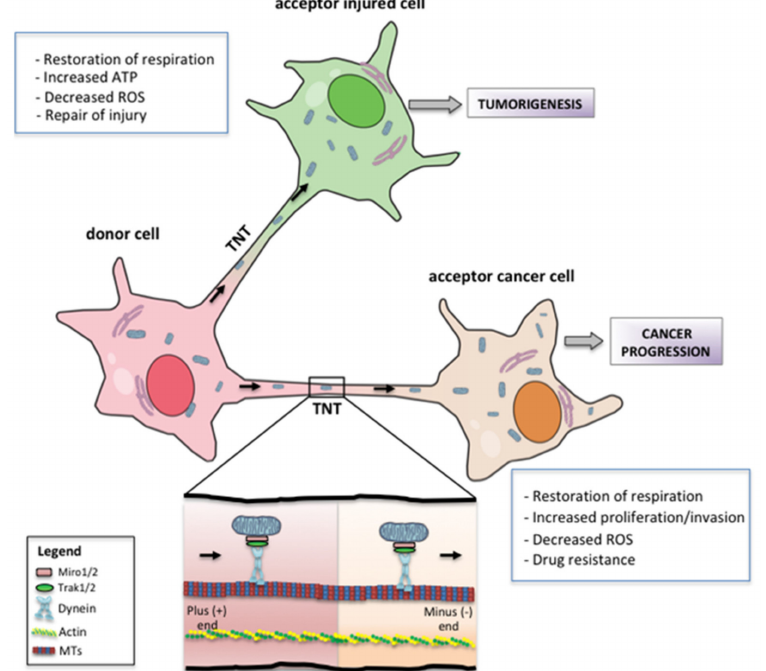
Figure 5. Mitochondrial transfer: Schematic representation of mitochondrial transfer via tunneling nanotubes (TNTs). The donor cell—generally a non-cancerous cell—moves mitochondria to the recipient cell, usually a cancer cell or an injured cell. The main advantages of mitochondrial transfer to acceptor cells are